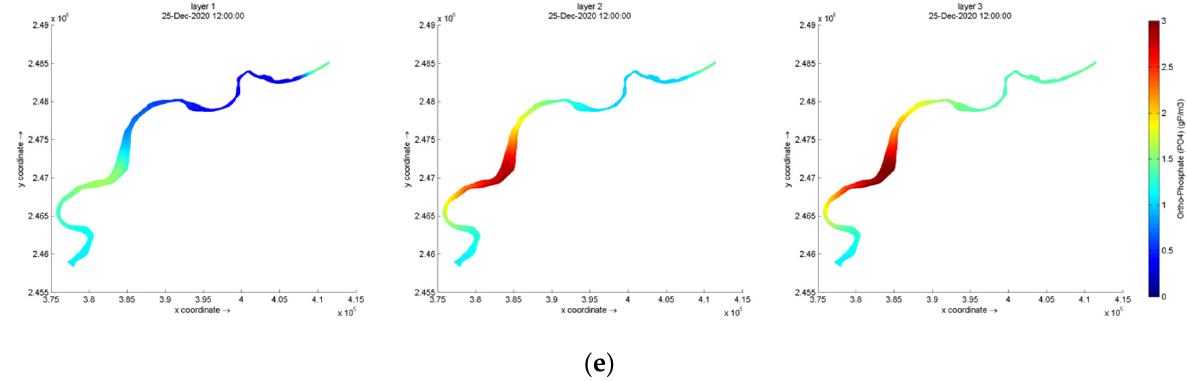
Figure 9. ( a ) Dissolved oxygen concentration throughout the study area. ( b ) Biochemical oxygen demand throughout the study area. ( c ) Chemical oxygen demand throughout the study area. ( d ) Nitrate-ion concentration throughout the study area. ( e ) Phosphate-ion concentration throughout the study area.